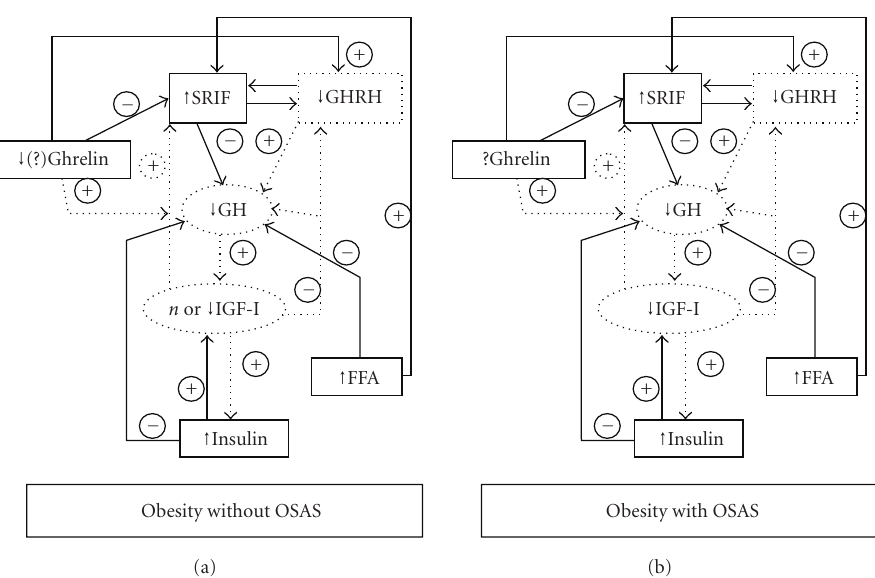
Figure 1: Regulation of GH secretion in obese patients without OSAS and obese patients with